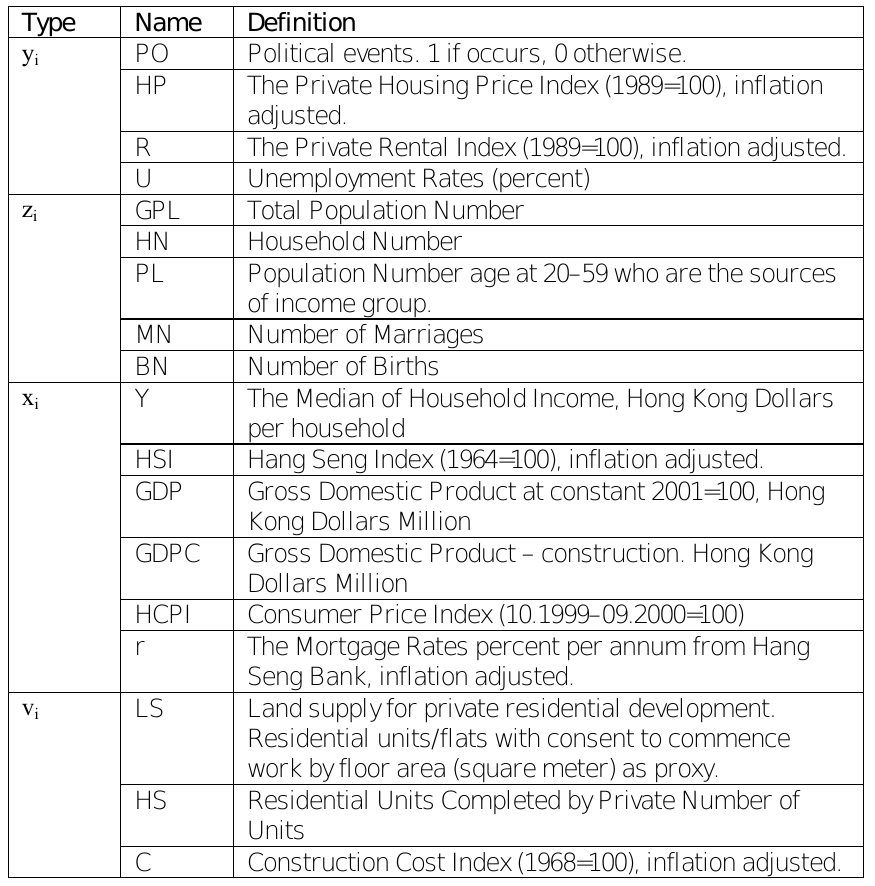
Table 5: Definition of